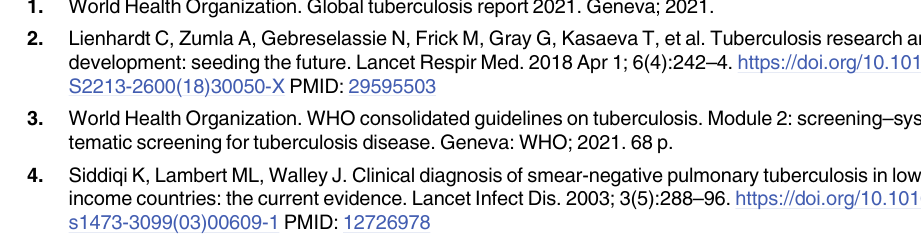
S1 Table. Sensitivity and specificity of ultrasound findings for bacteriologic TB in partici- pants with and without HIV. S2 Table. Ultrasound findings in participants with bacteriologic TB compared to healthy